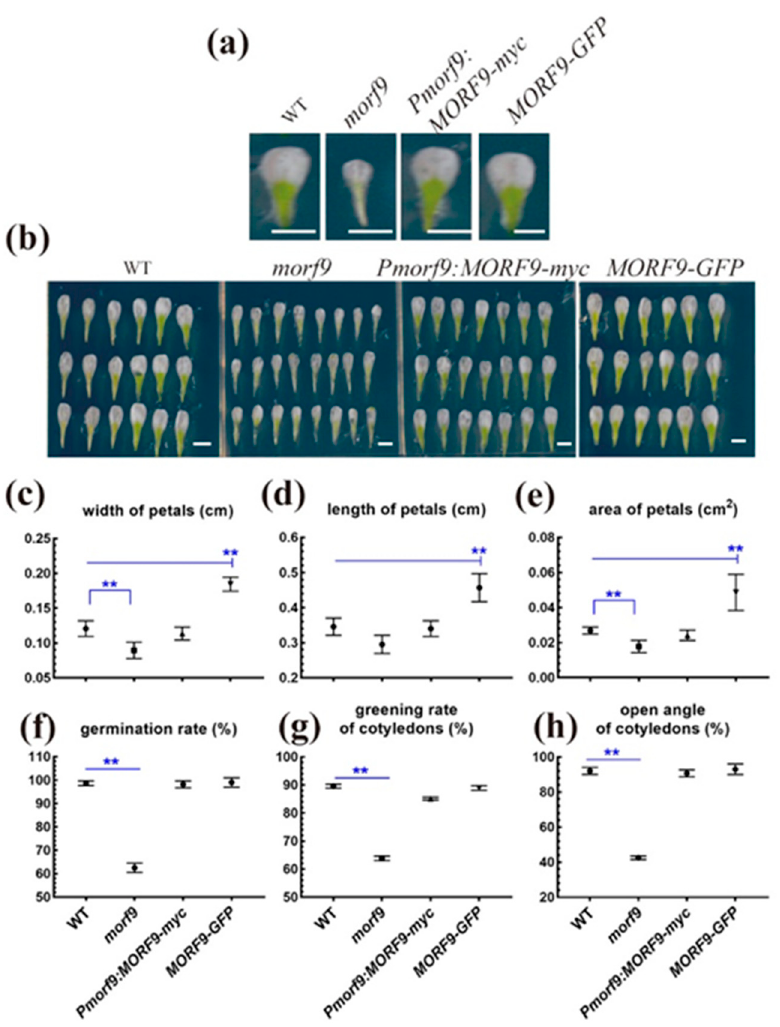
Figure 3. Flower phenotype and seed germination in the morf9 mutant and MORF9 transgenic plants. ( a , b ) Representative images of flowers in 56-day-old plants. Scale bars = 10 mm; ( c – e ) Flower dimensions of the indicated plant lines; n = 18–24; ( f ) Seed germination rate on the 5th day. Three independent experiments with n = 1500; ( g ) Cotyledon greening rates in the 5-day-old plants. Three independent experiments with 100 seedlings each; ( h ) Open cotyledons in 5-day-old plants. Three independent experiments with 100 seedlings each. Error bars indicate the standard errors of the replications. Asterisks indicate significant differences from the WT according to two-tail Student’s t test (* denotes p < 0.05, ** for p < 0.01 and *** for p < 0.001).